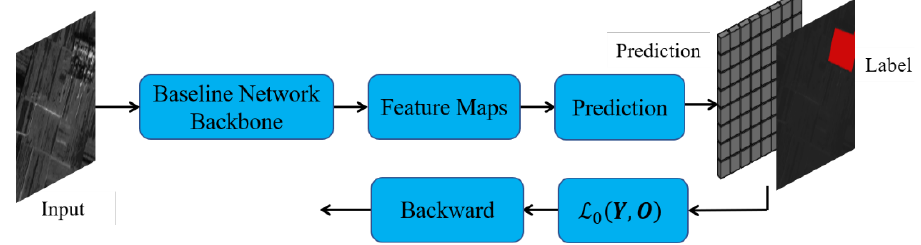
Figure 7. Traditional semantic segmentation network (previous).